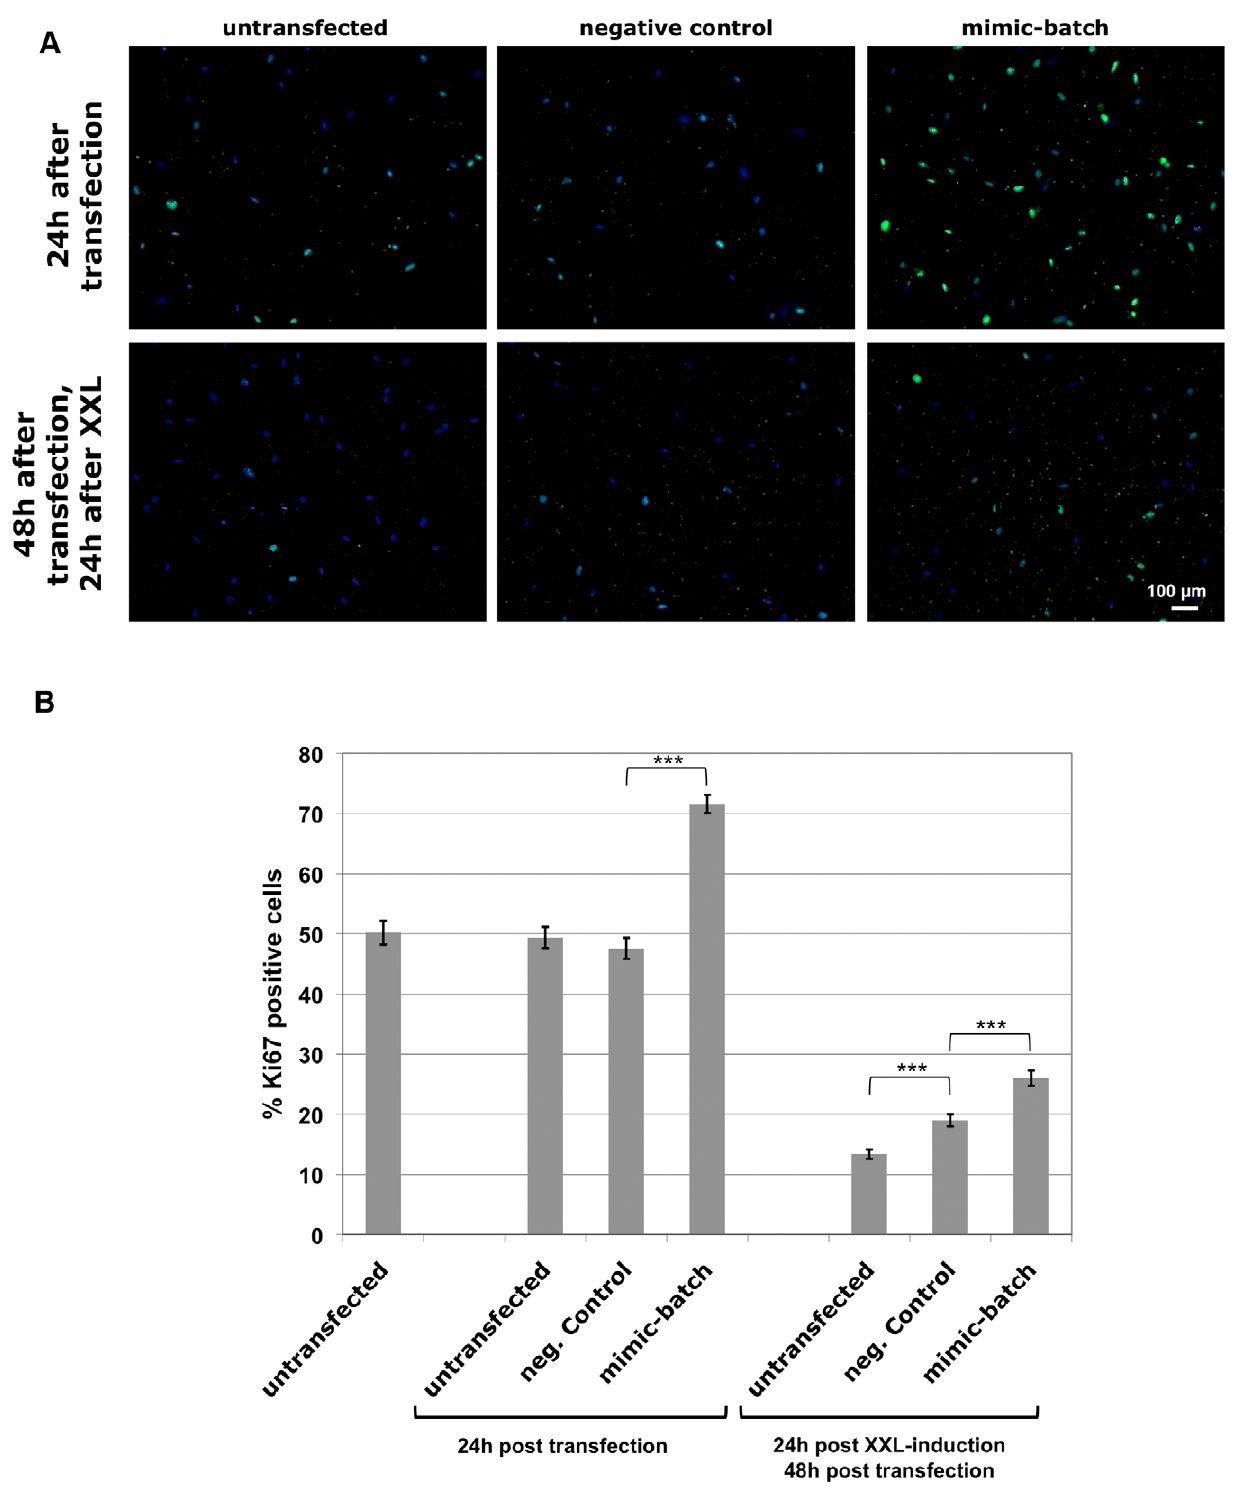
Figure 3. Proliferation-activating effect of microRNA mimics to miR-17, miR-20a, and miR-106b in USSC. (A) USSC line SA5/03 was transfected with a negative control mimic or an equimolar batch of miR-17-, -20a-, and -106b-mimics and induced to neuronal lineage differentiation using XXL–medium 24 h after transfection. Cells were immunostained for proliferation marker Ki67 and DAPI-stained. Ki67 (green)/DAPI stains from time points 24 h and 48 h after transfection are shown from untransfected SA5/03, and from SA5/03 transfected with negative control mimic and the mimic batch, respectively. (B) Increase of Ki67 expression in native USSC as well as in XXL-USSC upon miR-17-, -20a- and -106b-mimics-batch transfection. Combined results from counting of 1500–3000 Ki67/DAPI-stained cells/experimental condition from two biological replicates with 3 technical replicates each are given, together with standard error of the means and statistical significancies (Student’s t -test, unpaired: ***: p # 0.001).